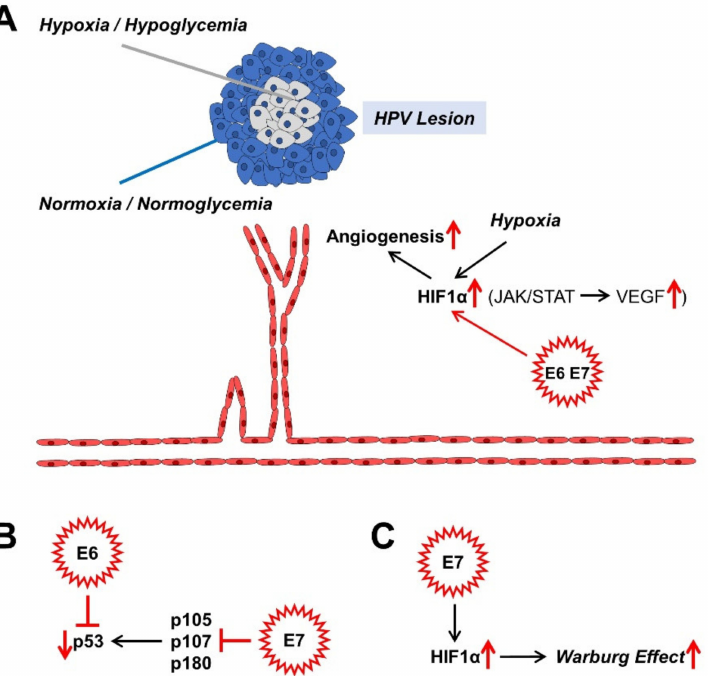
Figure 3. Effects of HPV oncoproteins on angiogenesis ( A ), malignant transformation ( B ), and metabolism ( C ). The mechanisms shown are mainly described in sections: 4.2. ( A ), 4.3. ( B ), and 4.4. ( C ). HIF1 α , hypoxia-inducible factor 1 α ; JAK, Janus kinase; STAT, signal converter and transcription activator; VEGF, vascular endothelial growth